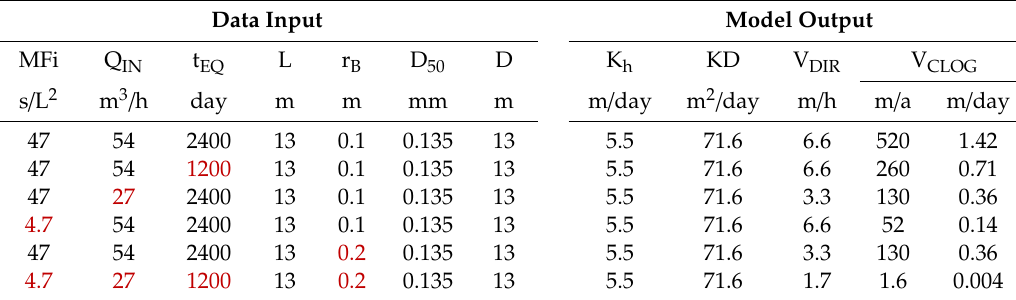
Table 7. Predicted injection well clogging (v CLOG ) as function of the membrane filter index (MFI) and other parameters. Method based on Buik & Willemsen [23], see Section 2.6. Red numbers: significant scenario